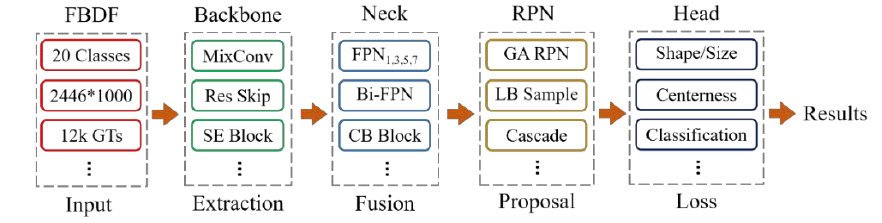
Figure 2. End-to-end fabric defect detection architecture.